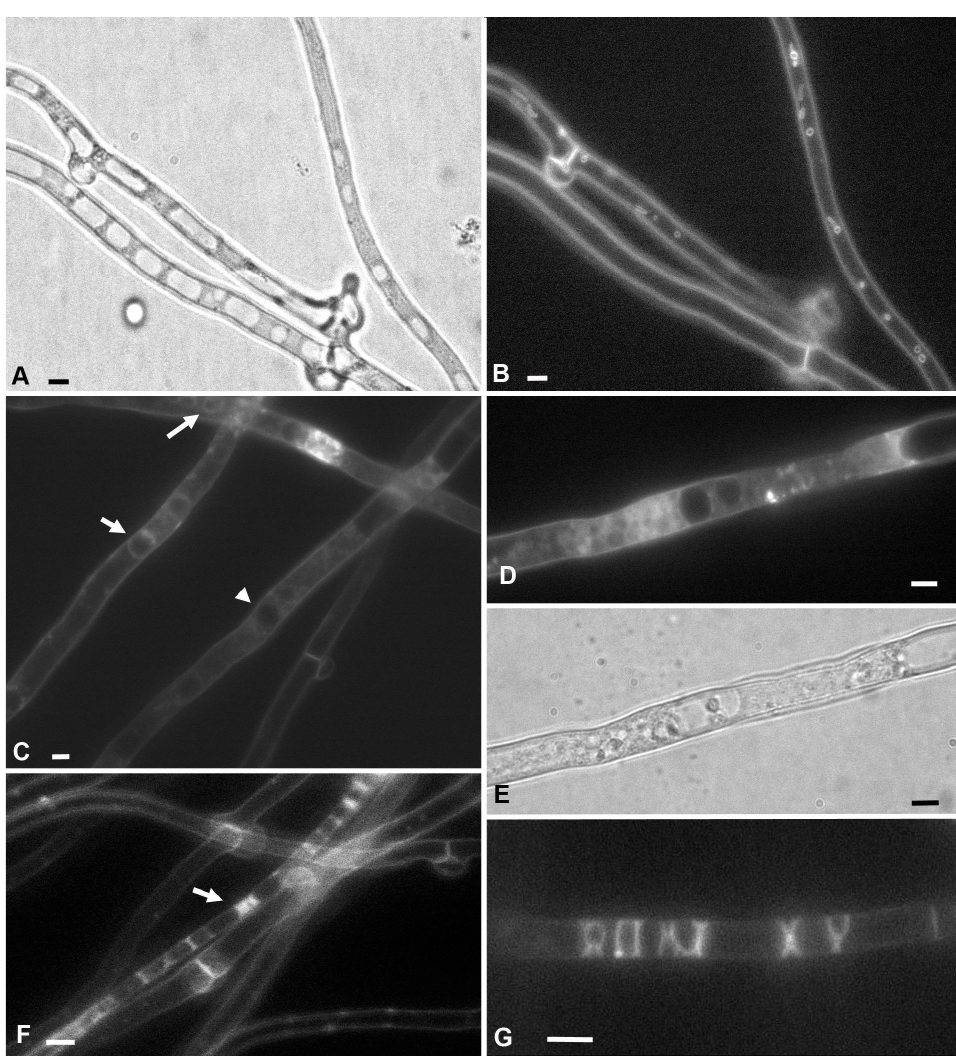
Figure 1. Three types of hyphae in xylotrophic basidiomycetes (in the example of S. hirsutum ) differ in uptake of the AM4-64 fluorophore. ( A , B )—hyphae of the first type, with an absent or very weak AM4-64 signal in the cytoplasm and endomembranes. PM and its macroinvaginations are labeled. The bright-field photograph ( A ) clearly shows large vacuoles; on the fluorescent image of the same area of the mycelium ( B ), there are no vacuoles, but vesicular and tubular invaginations of the PM are visualized. ( C – E )—hyphae of the second type with a diffuse signal AM4-64 in the cytoplasm. ( C )—relatively weak fluorescence of the cytoplasm; vacuoles are seen either as dark areas (arrowhead) or have a weakly labeled tonoplast (arrows). ( D , E )—hypha with a more powerful diffuse signal in the cytoplasm ( D ) and the same sample region in the bright field ( E ). ( F , G )—the third type—motley hyphae. ( F )—arrow points to the motley hypha. ( G )—with the help of labeled areas of tonoplasts and the edges of plasmolytic protoplasts, the fungus wrote “ROXY XY”. Scale bars are 5 µm. In microscopic samples, the proportion of diffusely labeled and motley hyphae in- creases with the time of observation (see Video S2, observation during 20 min). When the slide with mycelium is mounted with water (hypotonic conditions), after about half an hour of observation, most hyphae become diffusely labeled or motley. Accordingly, only